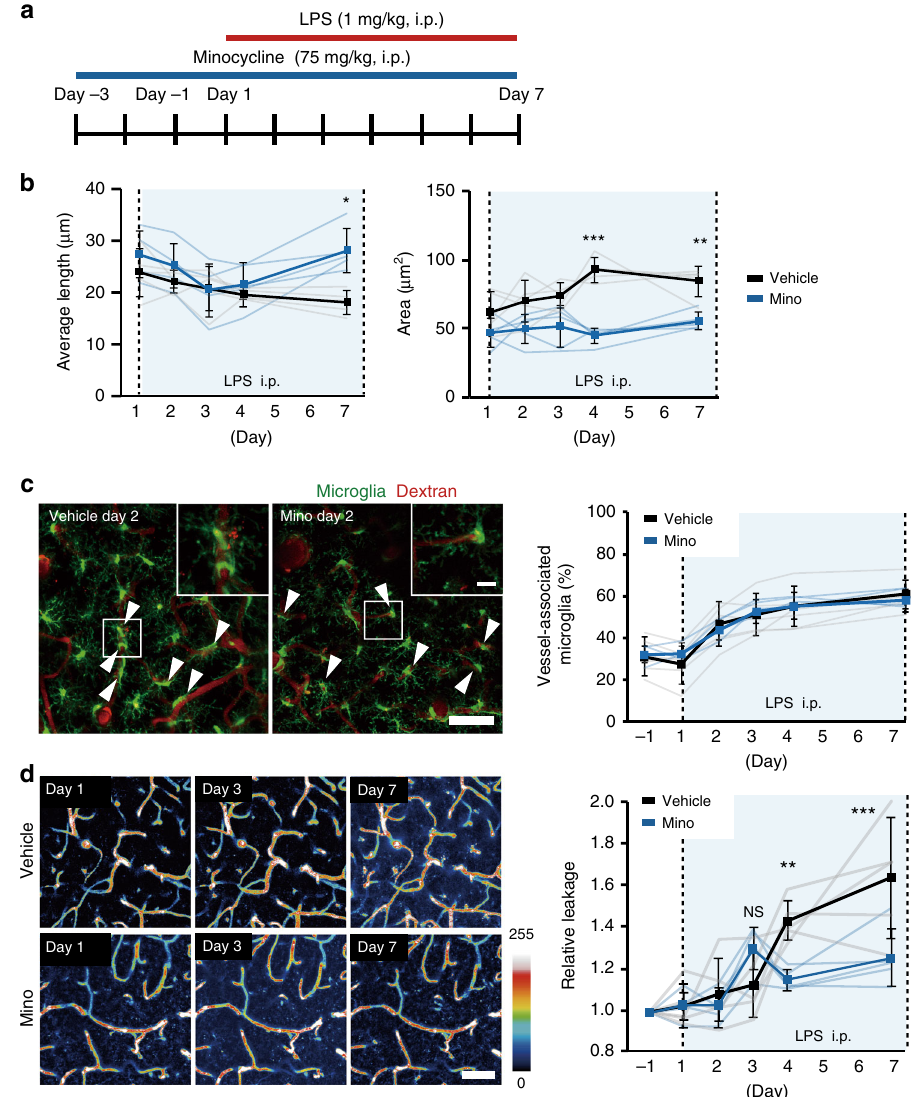
Fig. 7 Inhibition of microglial activation improves BBB integrity during the later phase of systemic in fl ammation. a Schematic diagram of the experimental protocol. Minocycline (Mino) (or vehicle) was injected 3 days before LPS injections. From Day 1, LPS and Mino (or vehicle) was co-injected daily for 7 days. Imaging was performed before (Day − 1) and on days 1, 2, 3, 4, and 7 days after LPS injections. b Graph plotting the effects of LPS on the mean length of microglial processes and on the mean area of microglia cell soma in vehicle and Mino-treated mice. c Typical in vivo two-photon images (left) and mean data (right) showed the effects on LPS on the proportion of microglia-associated with vessels. Mino did not affect the migration and accumulation of microglia at vessels. Scale bar, 50 or 10 μ m (inset). d (Left) A series of typical in vivo two-photon images from a single vehicle- (upper) or Mino- (lower) treated mouse demonstrated the changes in BBB permeability at different days after systemic LPS injection, measured by leakage of 10 kDa dextran from vessels. Scale bar, 50 μ m. (right) Plot of the effects of daily LPS injections on the dextran leakage from vessels. The relative leakage of 10 kDa dextran was signi fi cantly increased at 7 days after LPS injection in vehicle mice compared to Mino-treated mice. In each graph the faint lines indicate data from an individual animal ( b, c, d ) while the dark lines and error bars indicate the mean ± SD. NS not signi fi cant. * P < 0.05, ** P < 0.01, and *** P < package (open source software). Gene ontology (GO) terms were referenced from online tools in Metascape (http://metascape.org/) 67 . Electron microscopy with immunohistochemistry . To examine the 3D structure of microglia and vessels during immunostaining for CLDN5 and AQP4, serial images were acquired with 3D reconstruction using serial block-face scanning electron microscopy (SBEM) 68 . Brie fl y, the tissues were fi xed in 4% paraf- ormaldehyde solution in PBS and post- fi xed overnight in the same solution. Brains were cut with a vibratome into 200- μ m-thick sections, and freeze-thawed after in fi ltration of PBS containing 30% sucrose 69 . After blocking for 1 h in 5% BSA in PBS, slices were incubated overnight at 4°C with primary antibodies against CLDN5 (35-2500, Thermo Fisher Scienti fi c; 1:100) or AQP4 (AB3594, Merck KGaA; 1:500). The slices for CLDN5 immunostaining were heated at 95 °C for